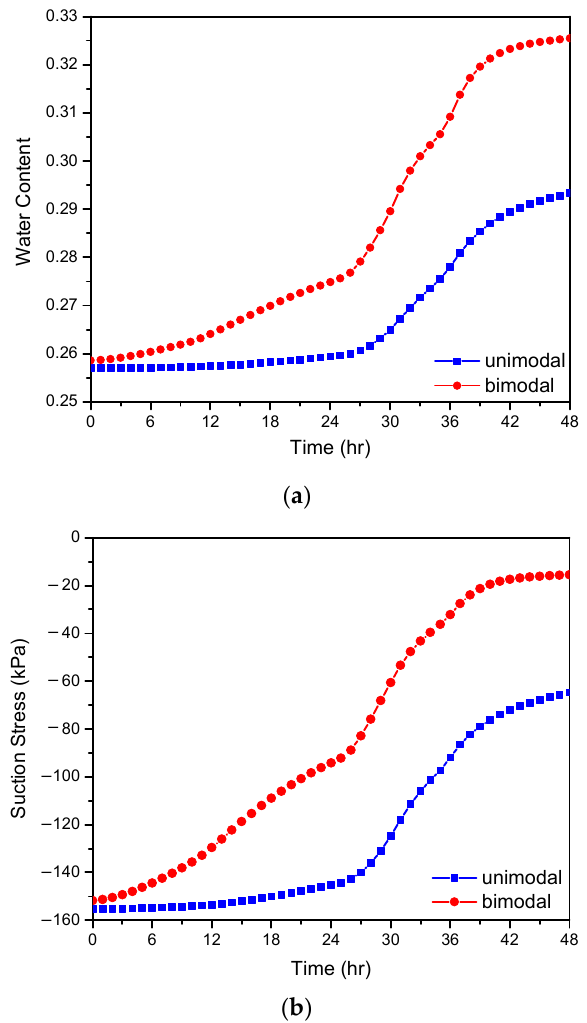
Figure 10. The changes of ( a ) soil water content and ( b ) soil suction stress in the unimodal and bimodal models at a depth of 0.85 m.